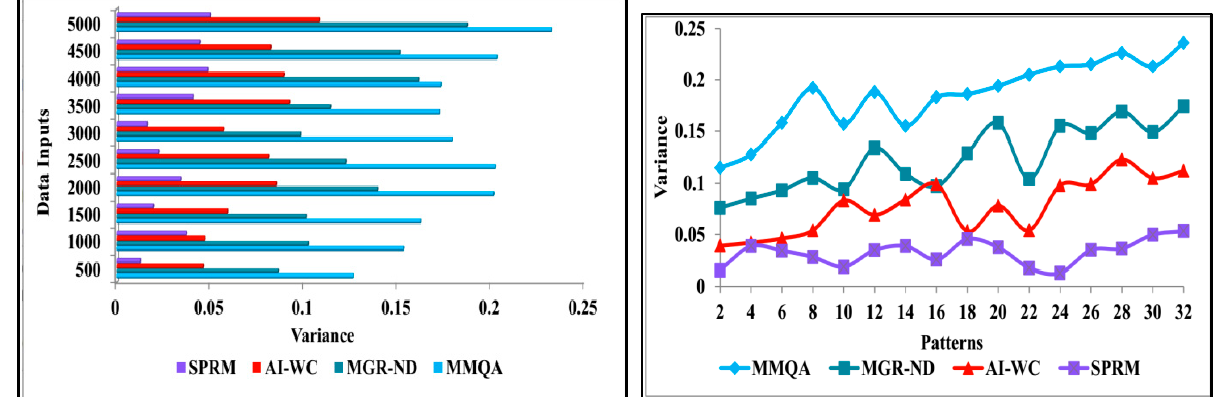
Figure 13. Variance analysis.